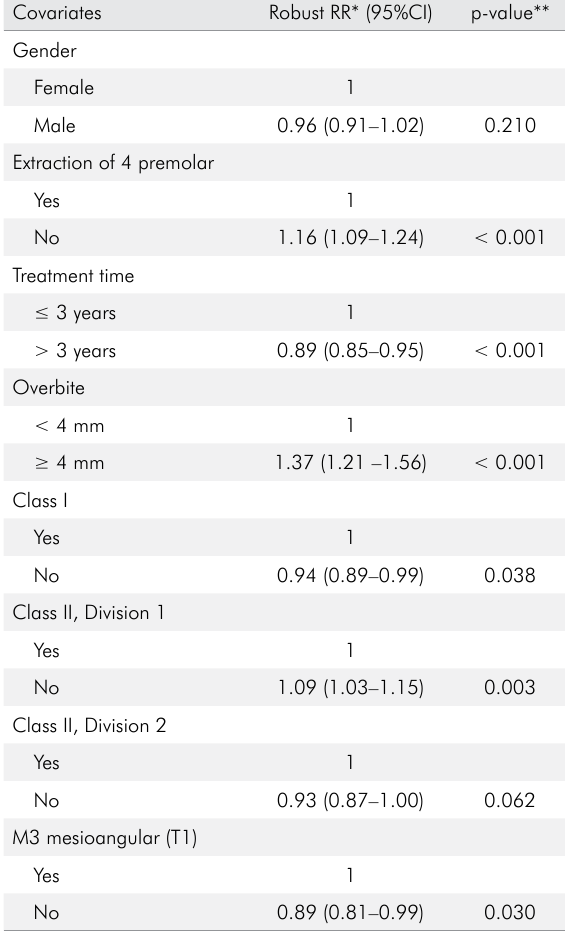
Table 2. Univariate analysis for association between impaction of third molar, characteristics of dentition and characteristics of treatment.